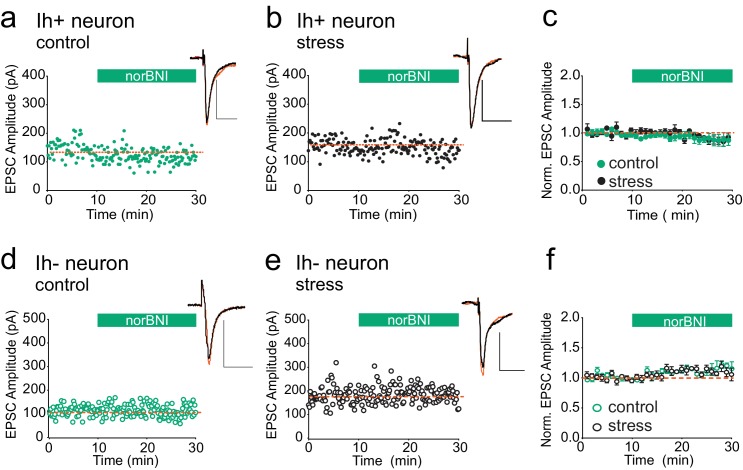
κORs at VTA excitatory synapses are not constitutively activated by stress.(A) Representative experiment showing that norBNI (100 nM) does not potentiate excitatory synapses on Ih+ VTA neurons in a slice prepared from a control animal. (B) Representative experiment showing that norBNI does not potentiate excitatory synapses on Ih+ VTA neurons in a slice prepared from a stressed animal. (C) Summary data from Ih+ neurons. No significant difference in IPSC amplitude 10–15 min after norBNI application (t-test p=0.81 IPSC amplitudes, control: 94 ± 2% of baseline values, n = 5; stressed: 92 ± 6% of baseline values, n = 6). (D) Representative experiment showing that norBNI does not potentiate excitatory synapses on Ih− VTA neurons in a slice prepared from a control animal. (E) Representative single experiment showing that norBNI does not potentiate excitatory synapses on Ih− VTA neurons in a slice prepared from a stressed animals. (F) Summary data from Ih− neurons. No significant difference in IPSC amplitude 10–15 min after norBNI application (t-test p=0.49 IPSC amplitudes, control: 112 ± 2% of baseline values, n = 5; stressed: 110 ± 4% of baseline values, n = 5).